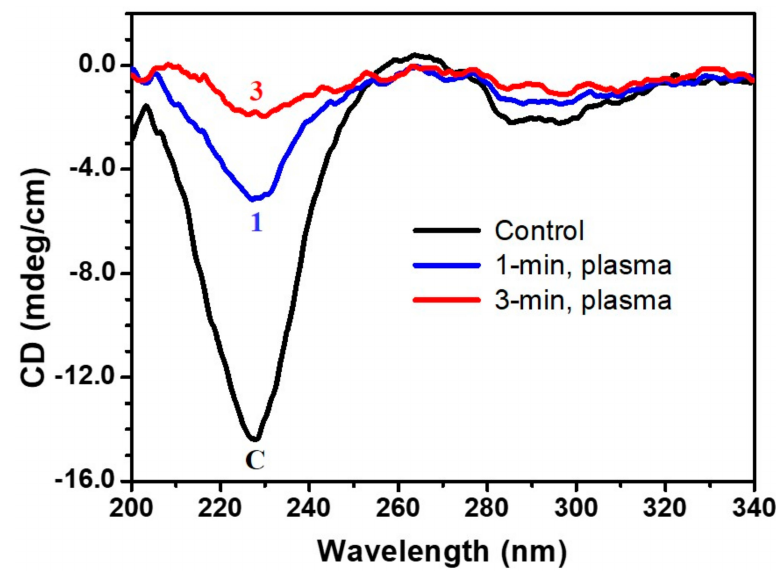
Figure 7. Circular dichroism spectra of the C . pruinosa spores treated by the soft plasma jet. C, 1, and 3 represent CD spectra of the control, 1 min, and 3 min plasma-treated C . pruinosa spores,